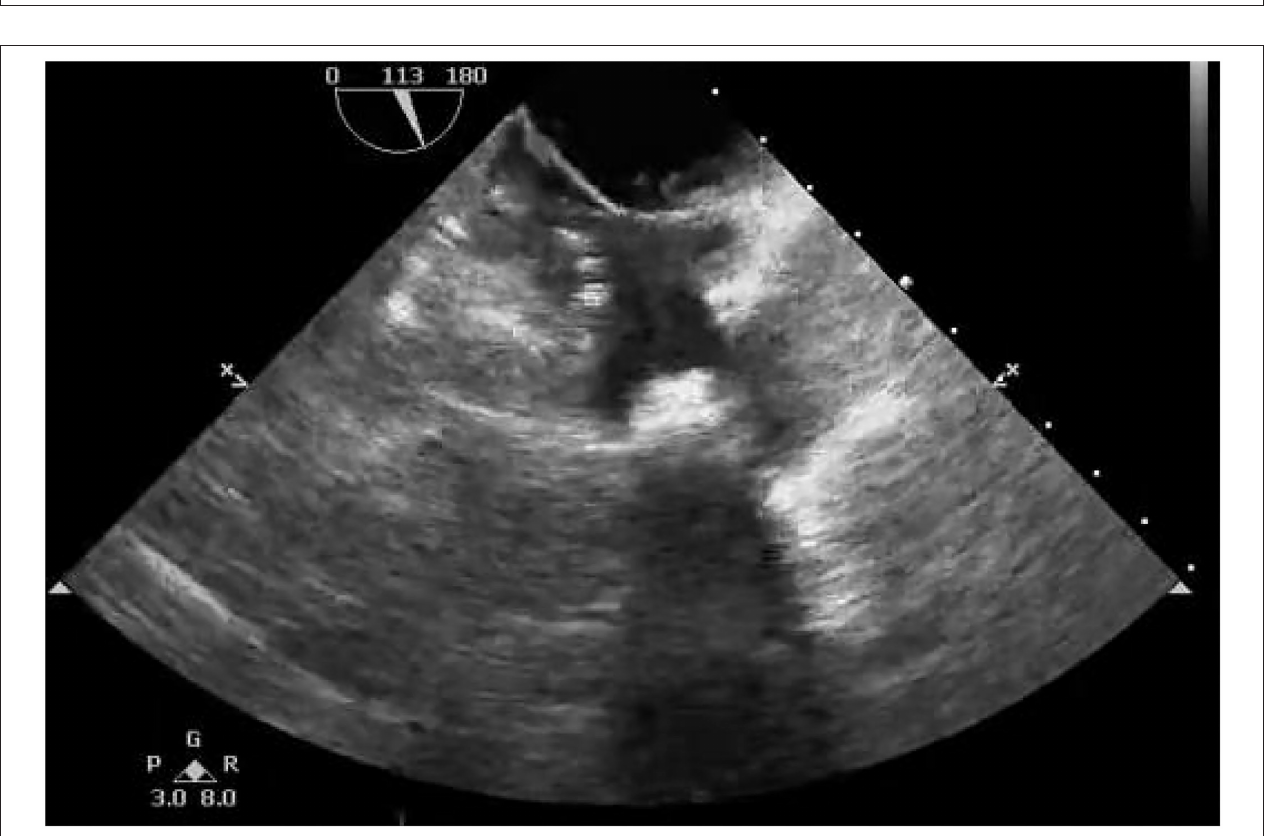
FIGURE 4 | Postoperative transthoracic echocardiography showing that no residual shunt through the atrial septum was detected.